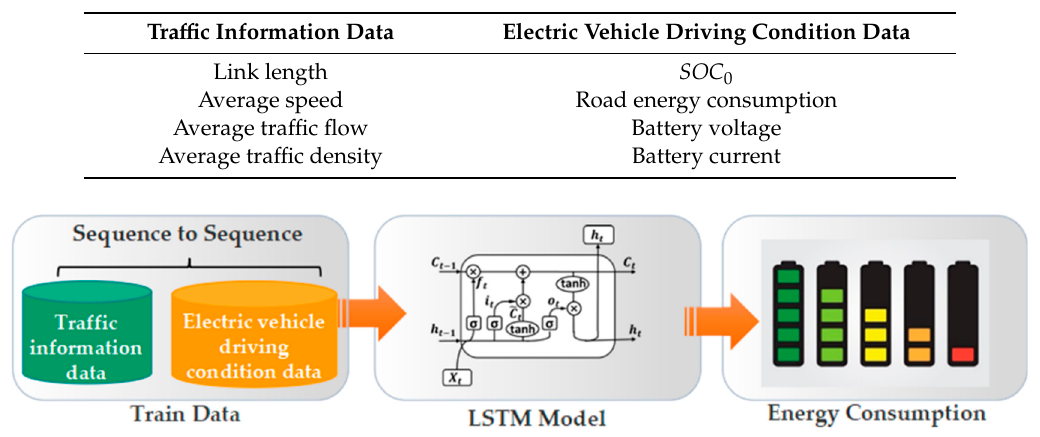
Table 5. Training data for the LSTM model.